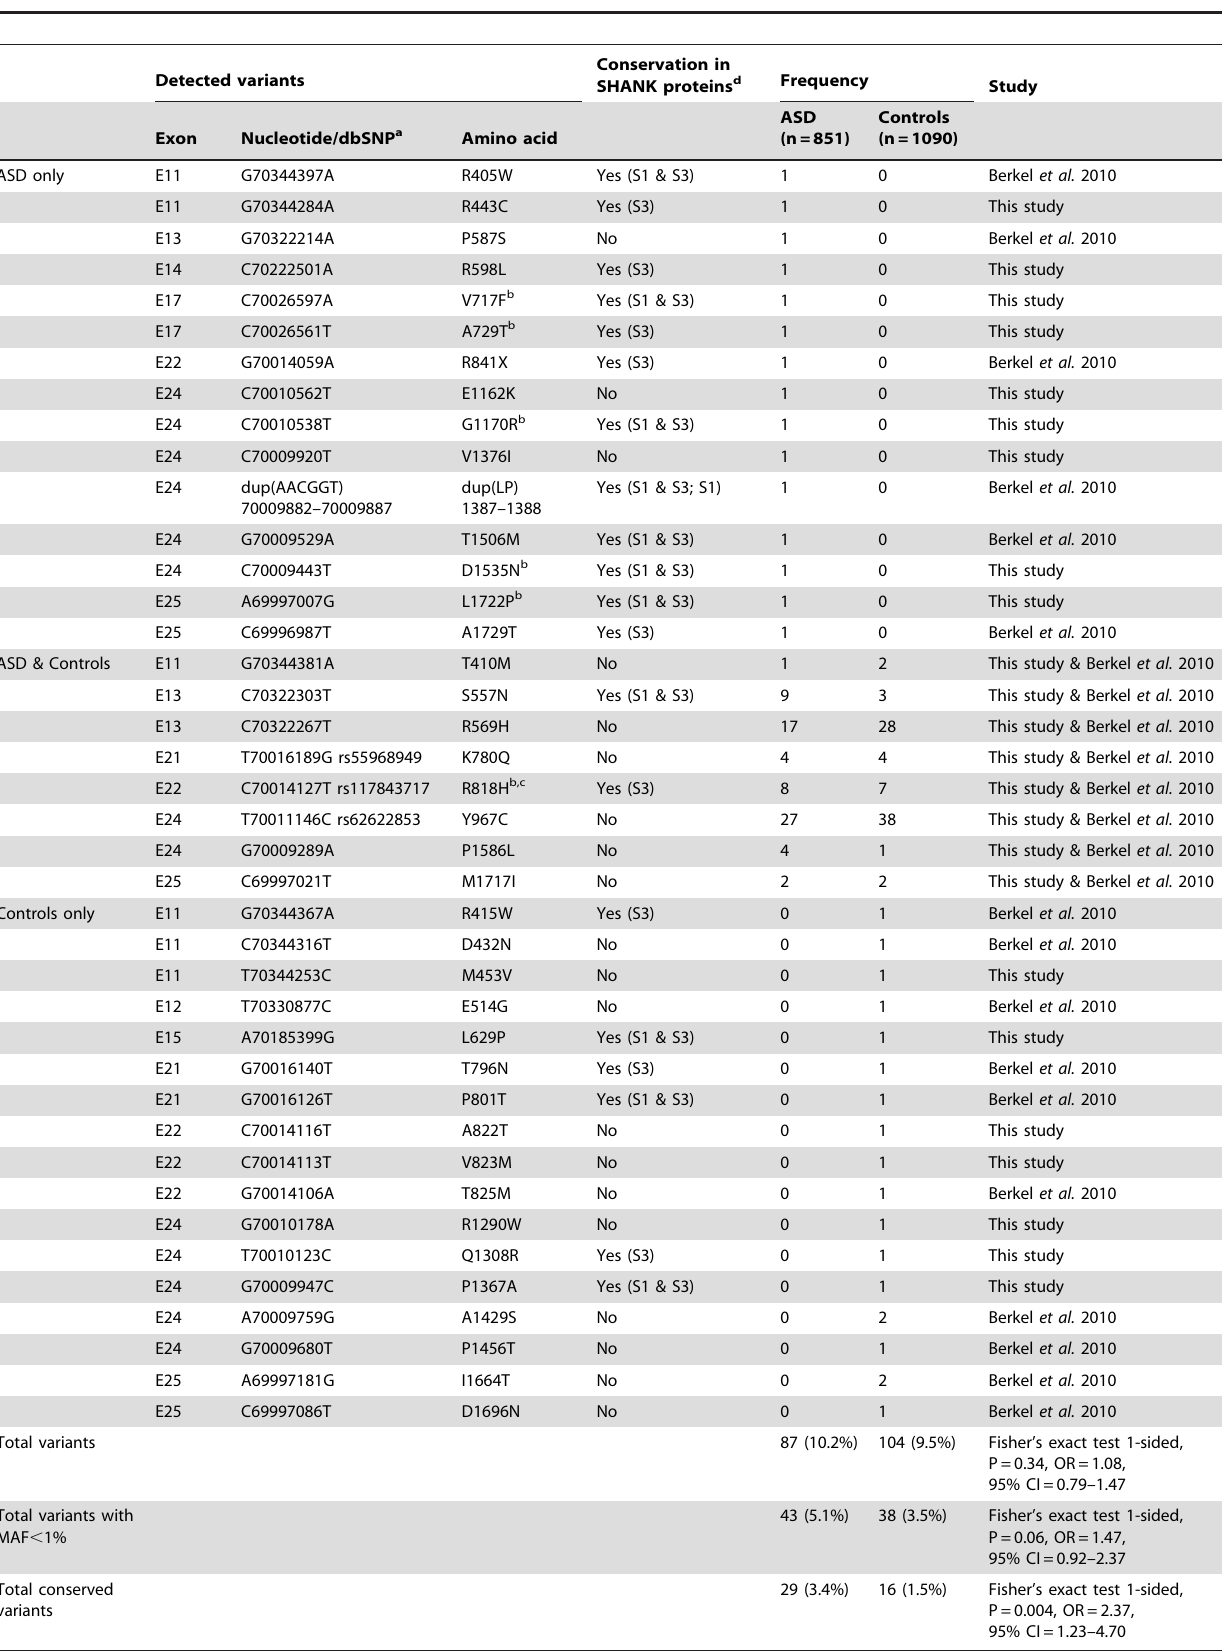
Table 1. ProSAP1A/SHANK2 variations identified in 851 patients with ASD and 1,090